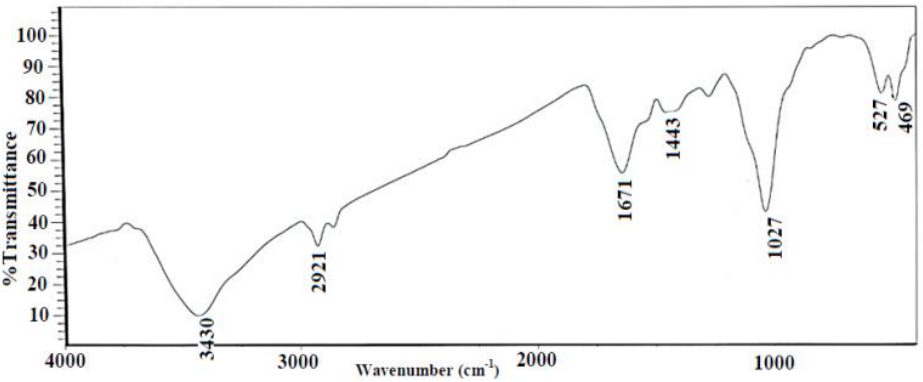
Fig. 6. FT-IR of Ag nanostructures -Echium amoenum extract